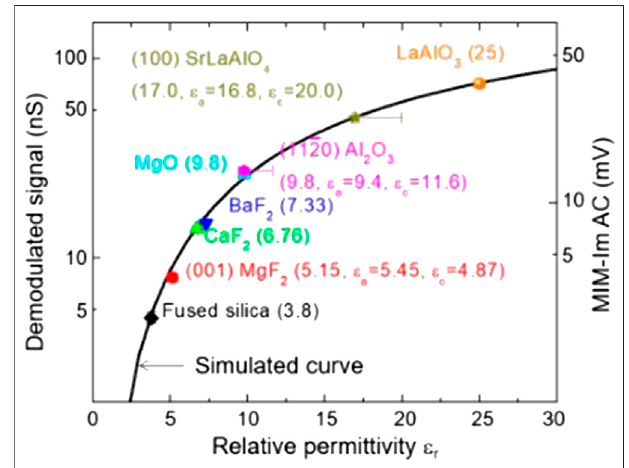
FIGURE8| Demodulatedtip-sampleadmittanceandthecorresponding MIM-Im AC signals as a function of the relative permittivity [69]. Reproduced with permission from Rev. Sci. Instrum. 89, 4 (2018). Copyright 2018 American Institute of